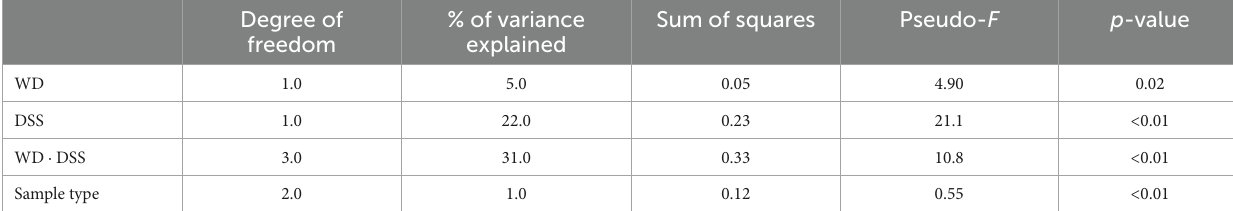
% of variance Sum of squares Pseudo- F p explained